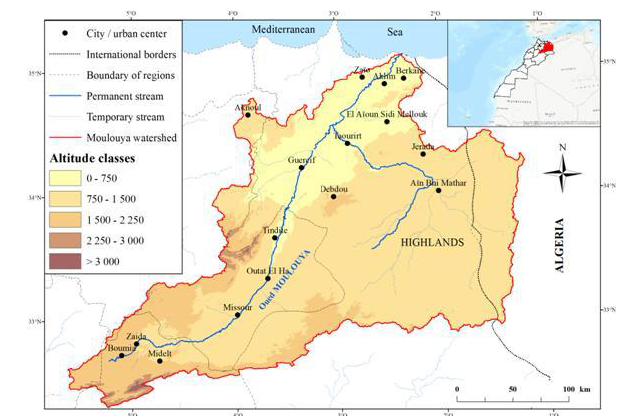
Figure 1. Location Map and the Moulouya Basin DEM (created by us based on layers of ASTER, GDEM, United States Geologi- cal Survey and https://www.openstreetmap.org/, last access: March